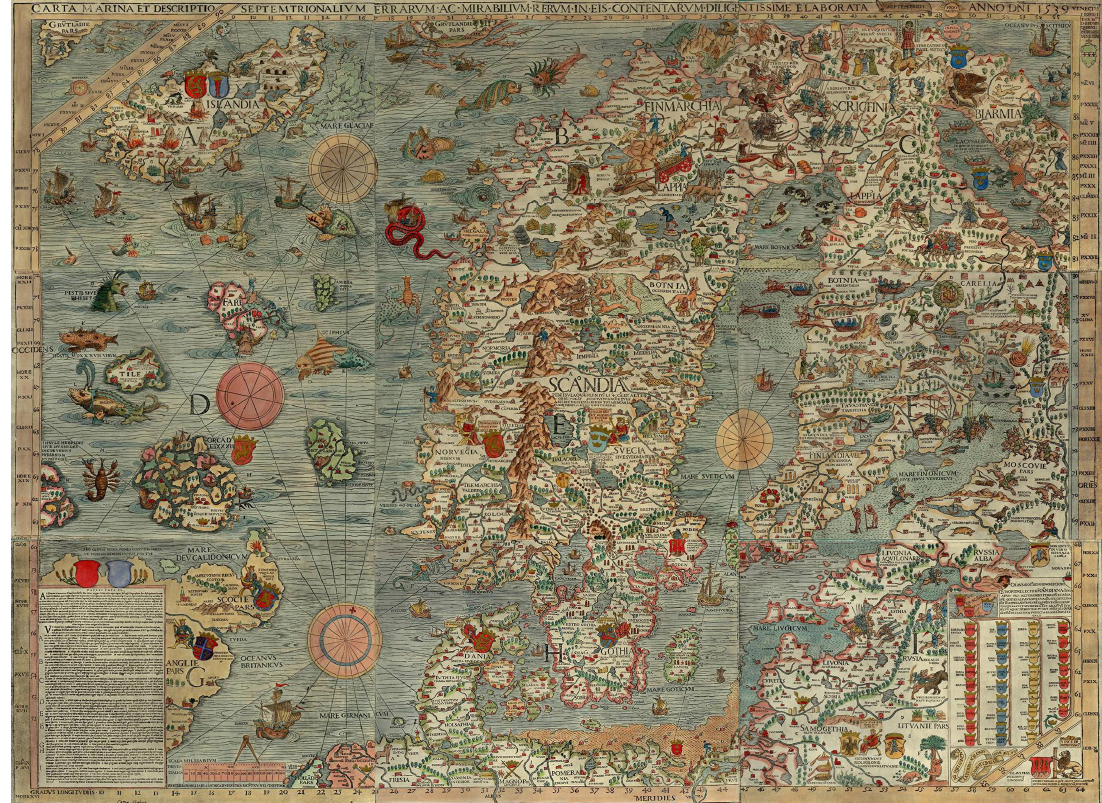
Figure 1. Carta Marina et descriptio septemtrionalium terrarum ac mirabilium rerum in